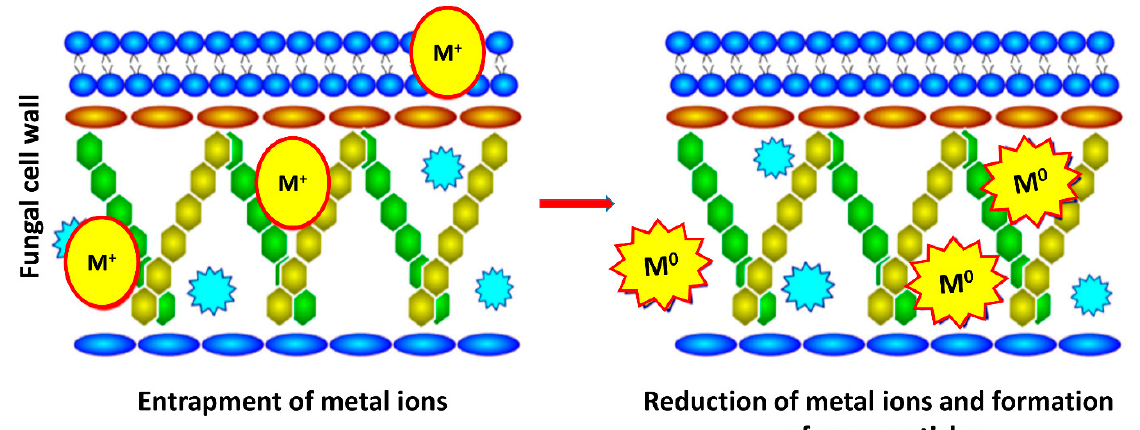
Figure 5. Hypothetical intracellular mechanisms for the synthesis of metal nanoparticles from F. oxysporum (Adapted and modified from Yadav et al. [13]; with copyright permission from Springer).